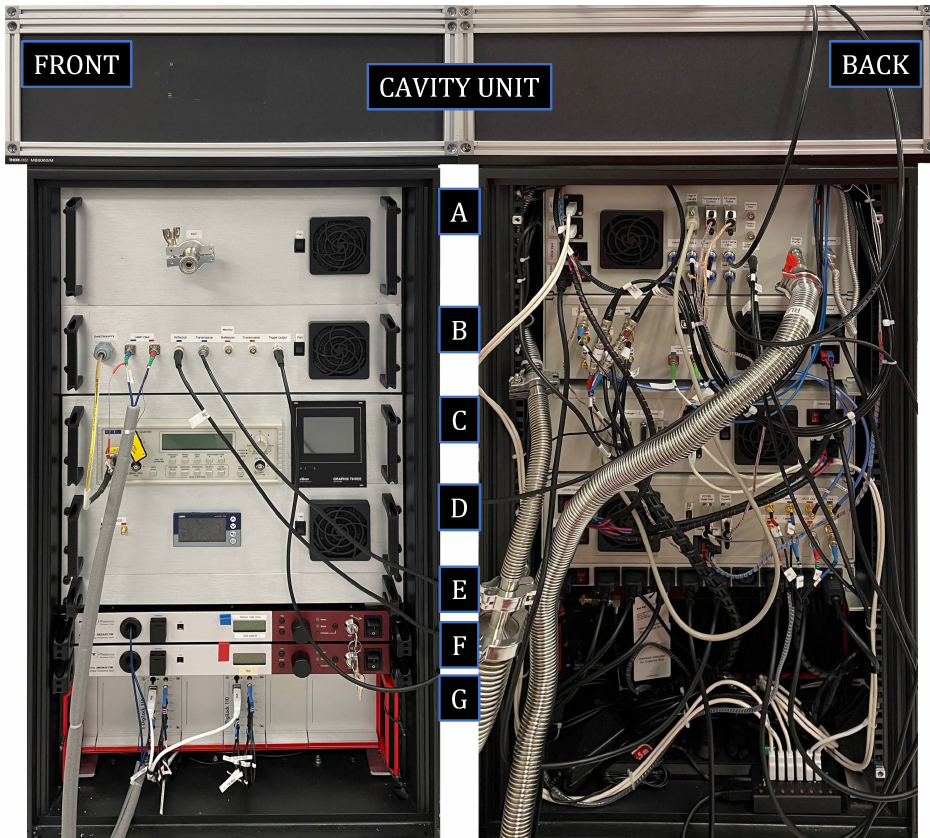
Figure 2. The TOP system seen from the front and rear. All lasers, electronics, and gas connections are placed within a 19-inch rack. On top of the rack, there is a 60 × 60 × 25 cm encapsulated box (denoted the cavity unit) that contains, as its base, an optical breadboard, on which the Invar-based DFPC is placed (in turn, encapsulated in an aluminum enclosure, denoted the “oven”). This unit also comprises four pneumatic valves that control the filling and emptying of gas in the cavity during the GAMOR-cycles (as can be seen in Figure 1, placed on top of the oven); and collimators, mirrors, and detectors that couple light into the cavities and measure the transmittance. The rack contains thereafter, from the top to the bottom, seven modules, denoted A–G, containing vacuum connectors, a communication hub, fiber-optics, a frequency counter, two fiber lasers, and locking electronics. The rack stands on four wheels that allow the system to be easily moved within the